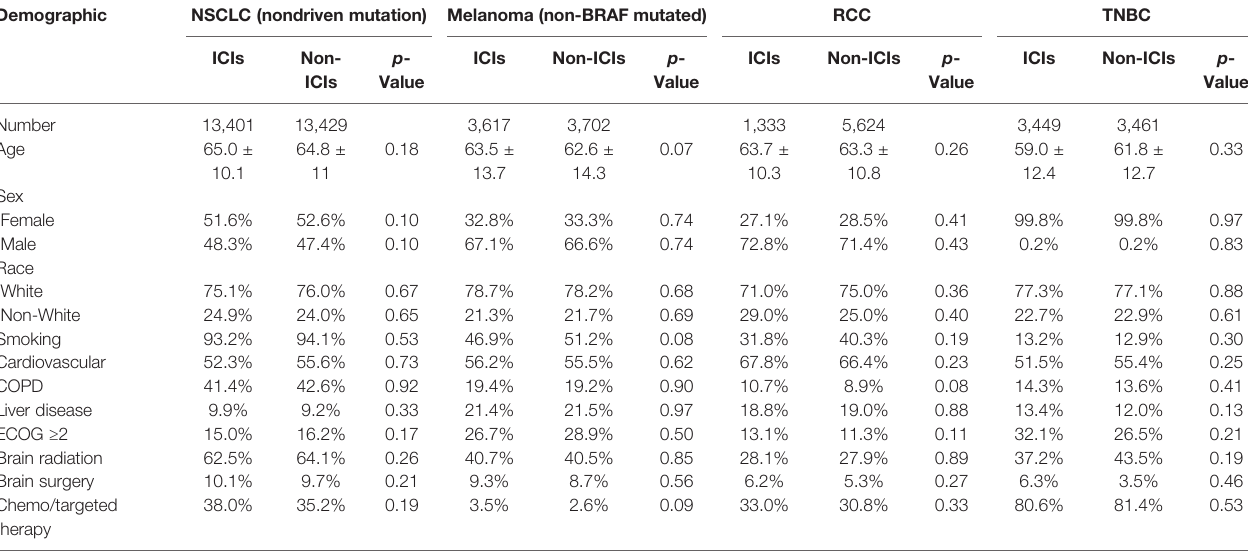
TABLE 1 | Demographic and clinical characteristics of patients with brain metastases.